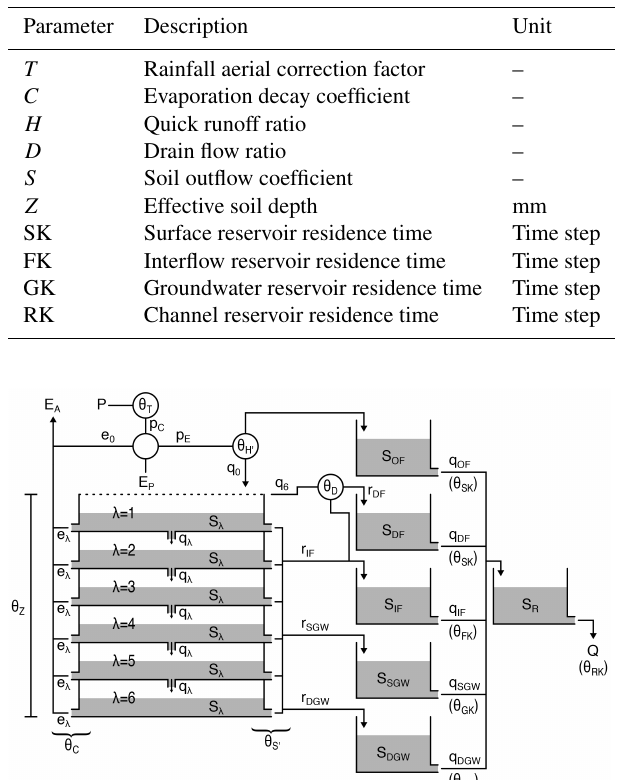
Table 2. List and description of the 10 parameters of the SMART model.